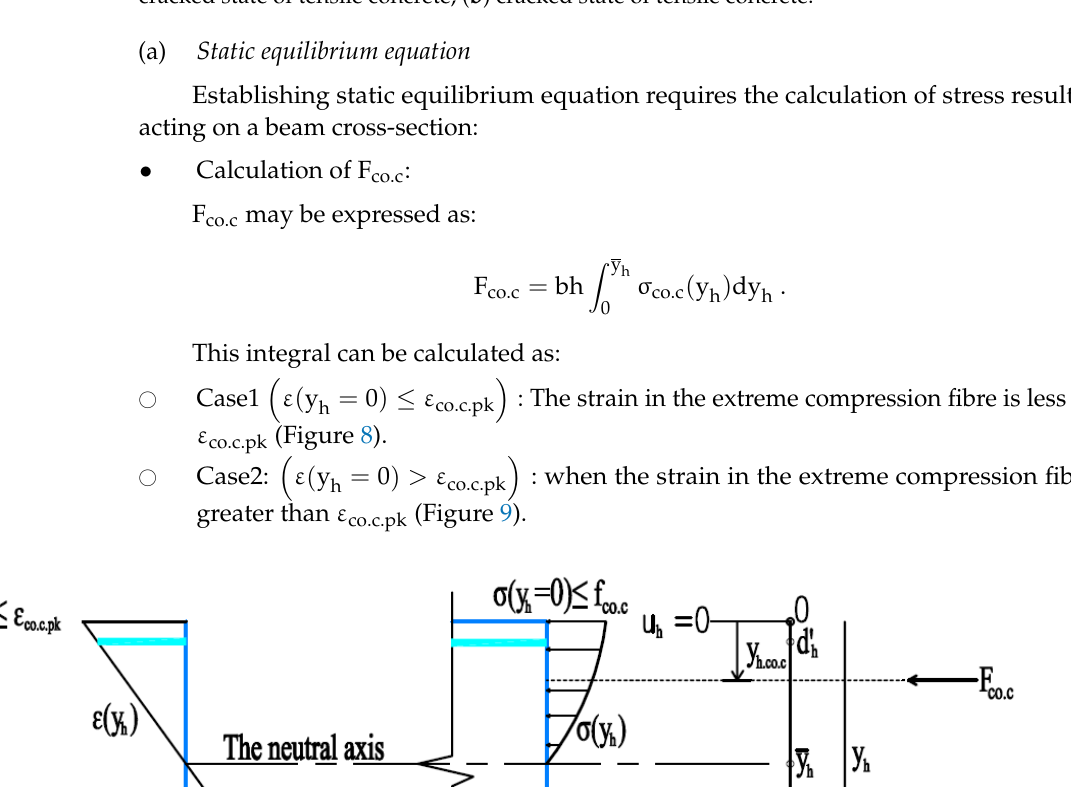
Figure 8. Stress–strain compressive concrete when (cid:3435)ε(y = 0) ≤ ε (cid:2913)(cid:2925).(cid:2913).(cid:2926)(cid:2921) (cid:3439).